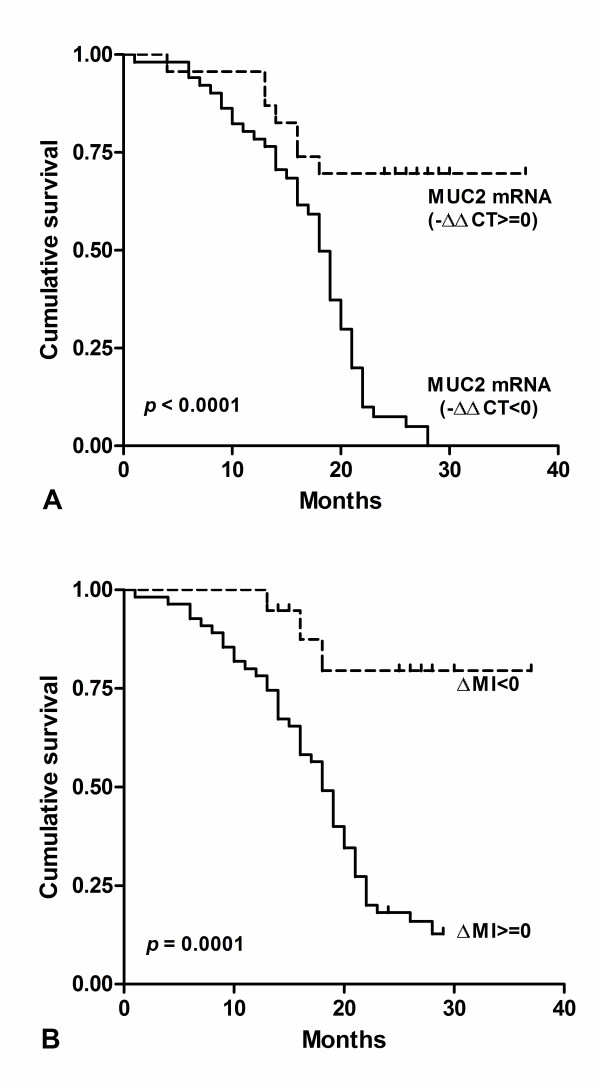
MUC2 mRNA and hypermethylation confers poor prognosis in HCC. (A) Kaplan–Meier analysis of survival months after surgery according to MUC2 mRNA level. (B) Kaplan–Meier analysis of survival months after surgery according to MUC2 methylation index.